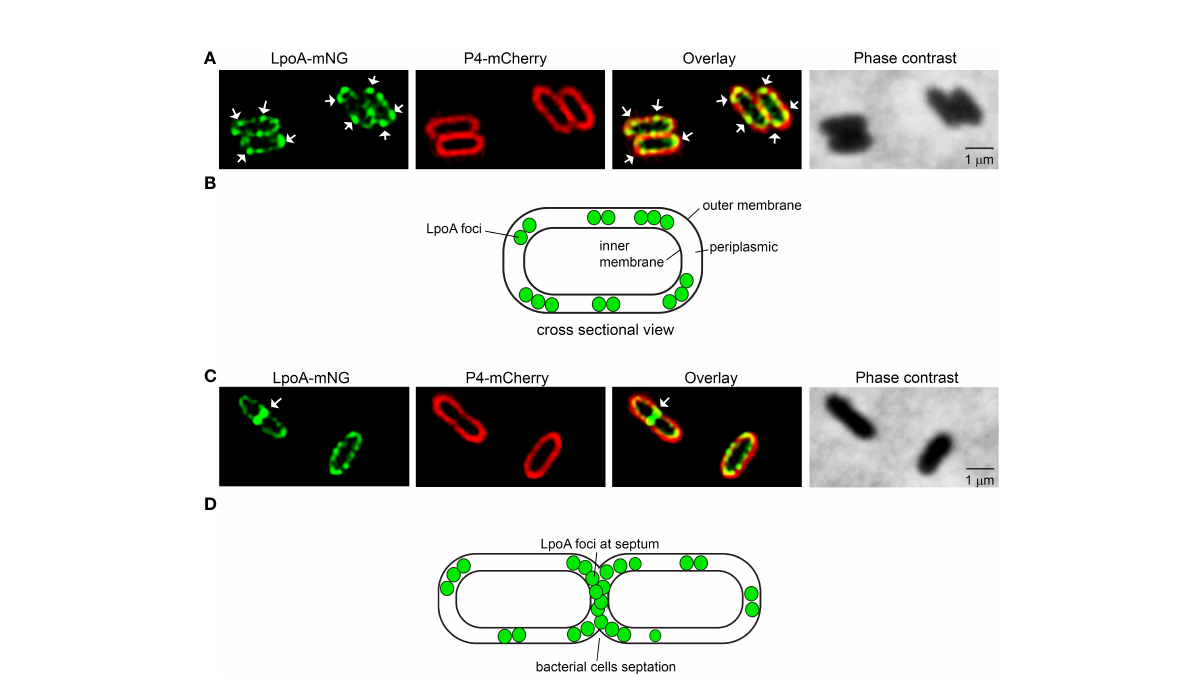
FIGURE 4 Fluorescence microscopy of H. in fl uenzae expressing LpoA-mNeonGreen and P4-mCherry. (A , C) H. in fl uenzae Rd pLpoA 1-576 + P4 mcherry captured with phase contrast imaging and fl uorescence channels detecting mNeonGreen and mCherry. Overlay of the fl uorescence shown. White arrows indicate concentration of LpoA-mNeonGreen in foci in the OM (A) and at the septum (C) . White arrows indicate LpoA-mNeonGreen in foci in the OM. All images were taken at 100x magni fi cation. Scale bars indicate 1 µM. (B, D) Cartoons indicating the localization of